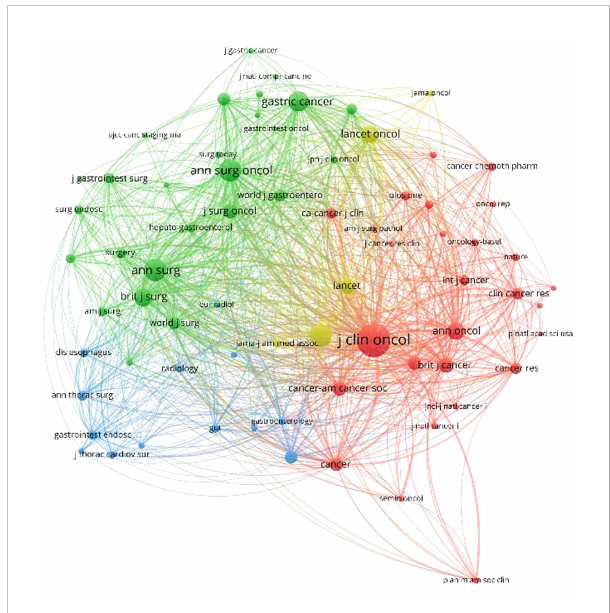
FIGURE 5 Density map of the co-cited journals, which published literature related to neoadjuvant chemotherapy for GC from 1991 to 2021.